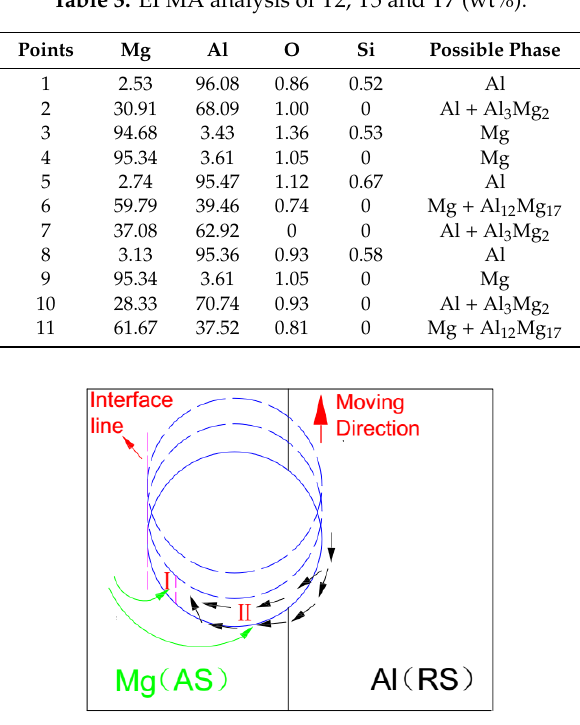
Figure 6. Materials flow sketching in stirring process with offset.